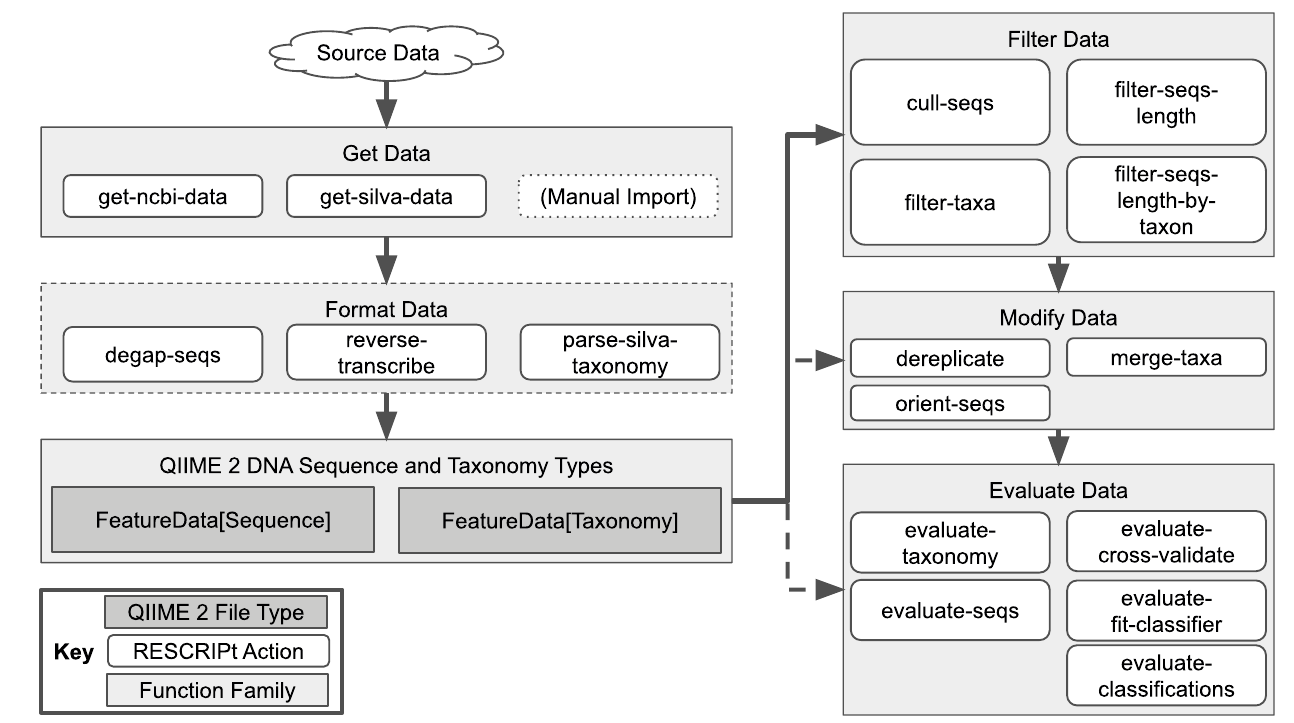
Fig 1. Current RESCRIPt functionality for processing and curating reference sequence data. Arrows indicate suggested workflows. Dotted arrows and edges indicate optional steps for customized workflows.